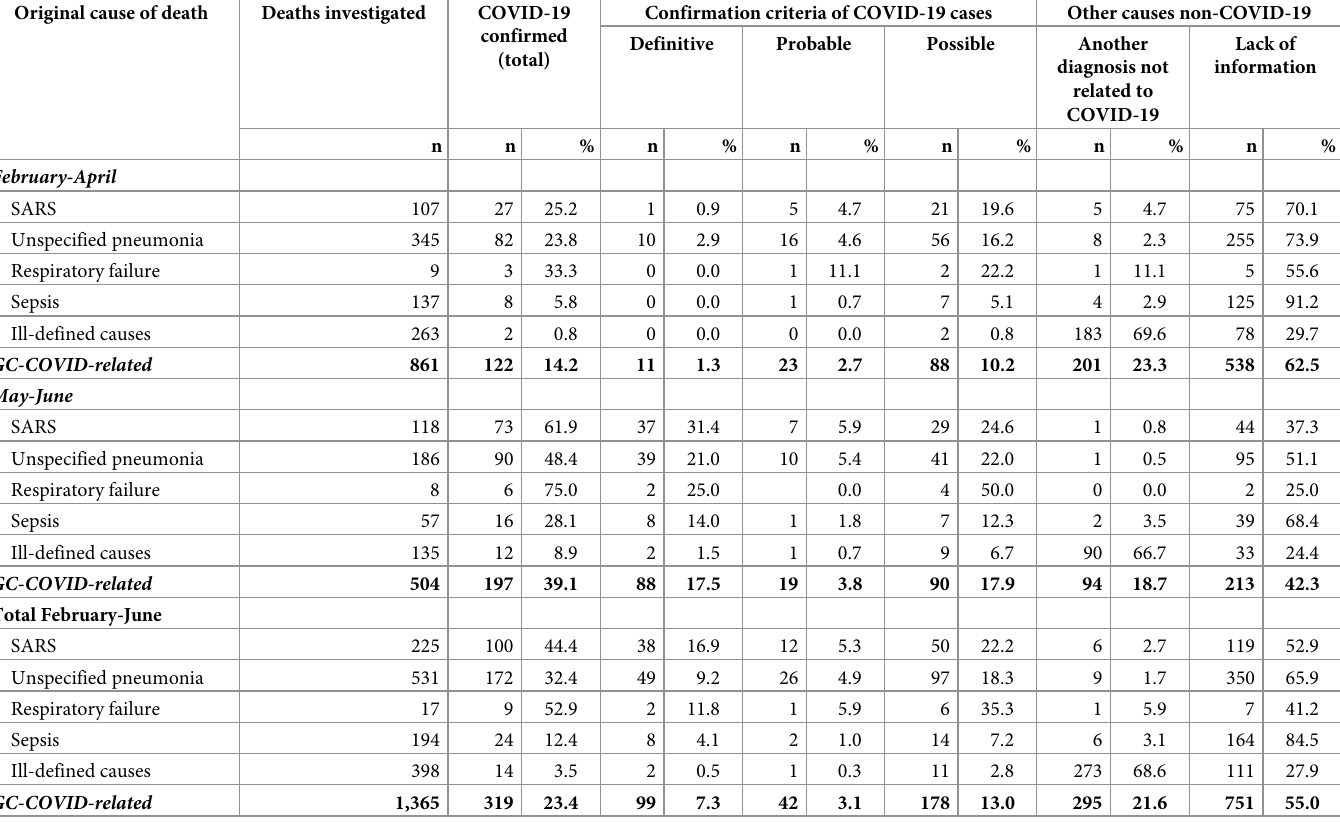
Table 2. Deaths from COVID-19 detected after investigation in selected municipalities according to confirmation criteria and period of occurrence. Brazil, Febru- ary-June